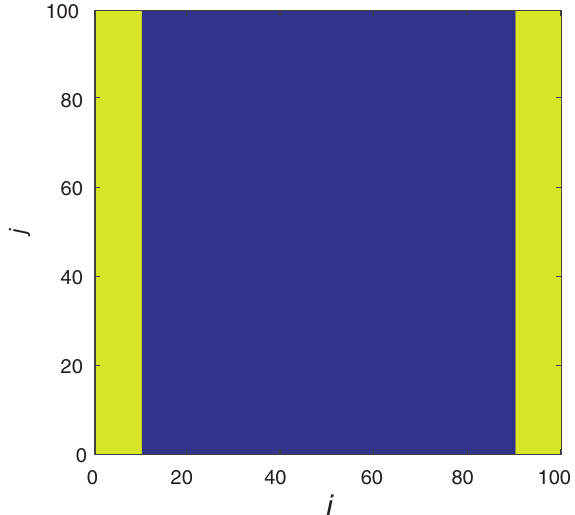
Fig. 7 The initial condition in the ABM for the unrealistic experiment. Yellow indicates a site occupied by an agent and blue indicates an empty lattice